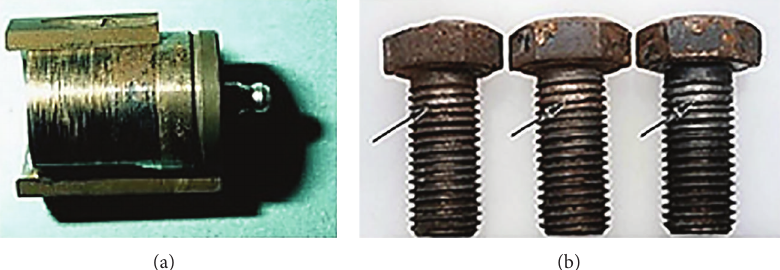
Figure 1: (a) Fretting corrosion at an axle-cylinder contact and (b) fretting wear on the threads of the caps crews [11].